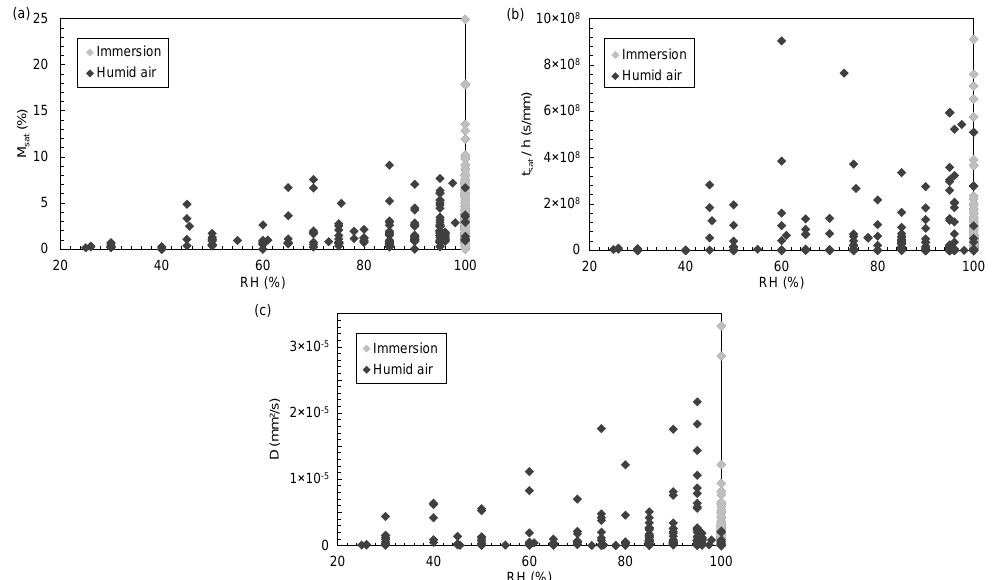
Figure 4. Evolution of ( a ) M sat , ( b ) t sat / h and ( c ) D as a function of relative humidity RH . In immersion in a liquid, C sat is related to the chemical potential of the water, i.e., it tends to decrease when the concentration of solutes increases [118]. The solvent concentra- tion [ S ] in an environment is in equilibrium with its partial pressure P s in the atmosphere. There is a maximum concentration [ S ] sat , which corresponds to the saturation pressure P sat (Equation